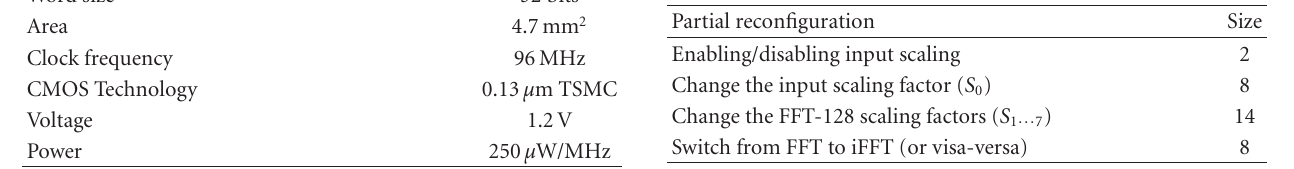
Table 6: Number of bytes required for partial reconfiguration of the FFT-1920.